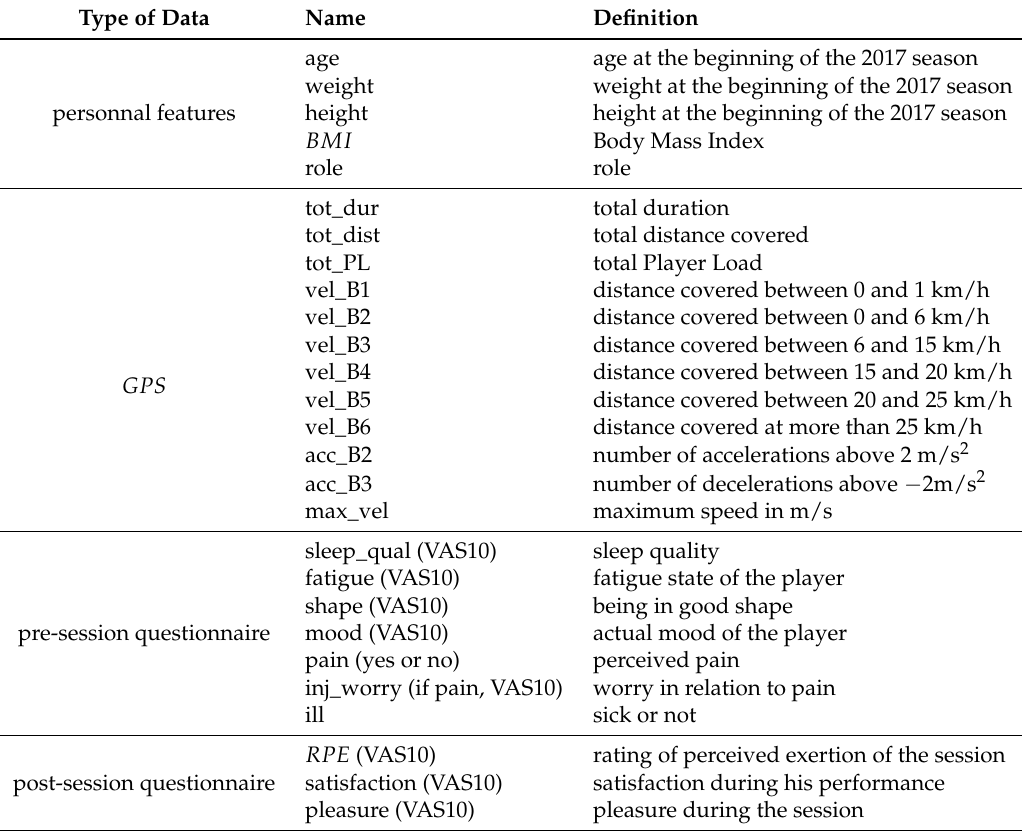
Table 1. Set of features used in the study. GPS is corresponding to features of external loads